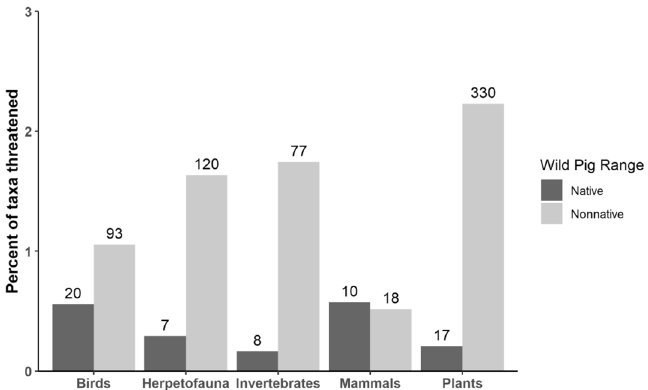
Figure 5. Percent of all taxa (extant or extinct) described as being threatened (major, minor, or potential) by wild pigs on the IUCN Red List within their native (dark gray bars) and non-native (light gray bars) range. Numbers above bars are the total number of taxa threatened by wild pigs for each